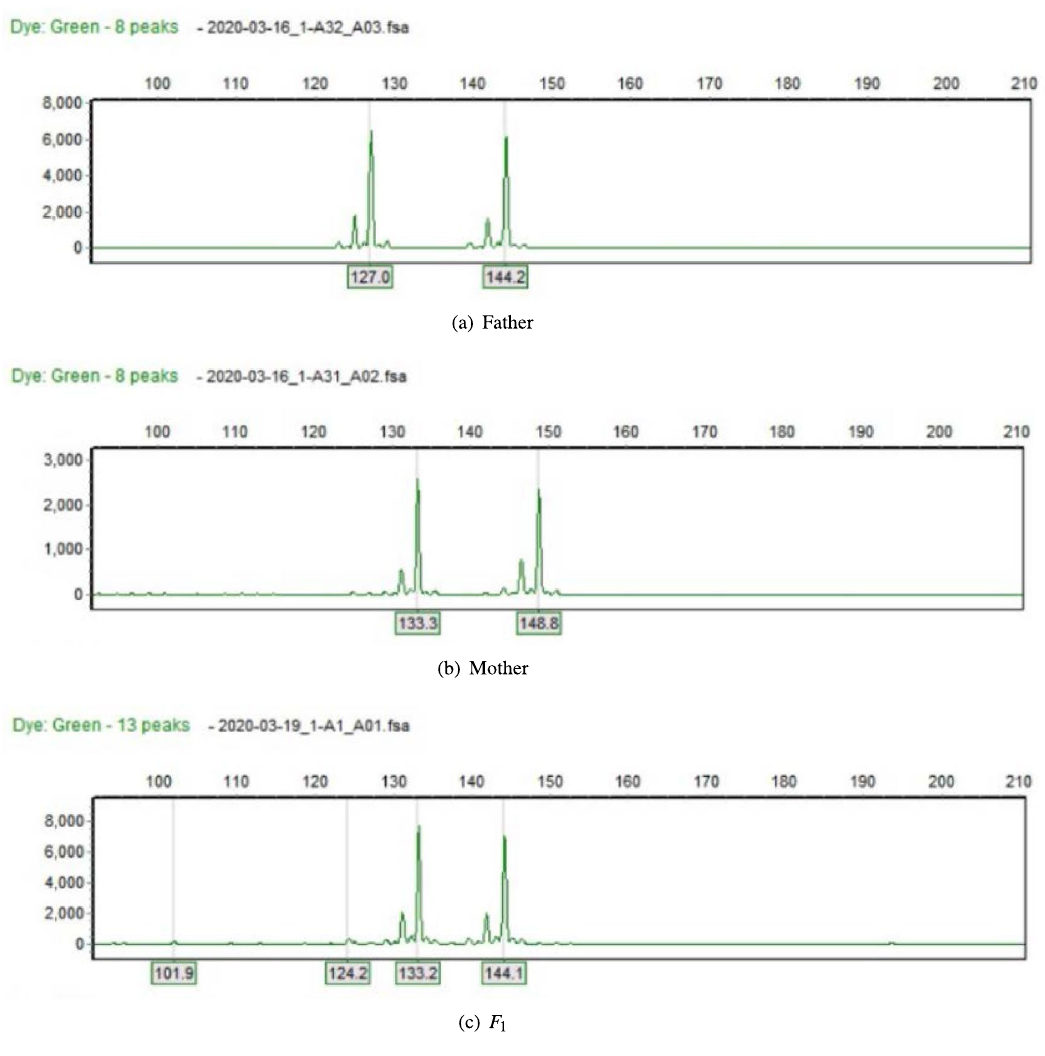
Figure 1. The heterozygous type.Peak value represents segment